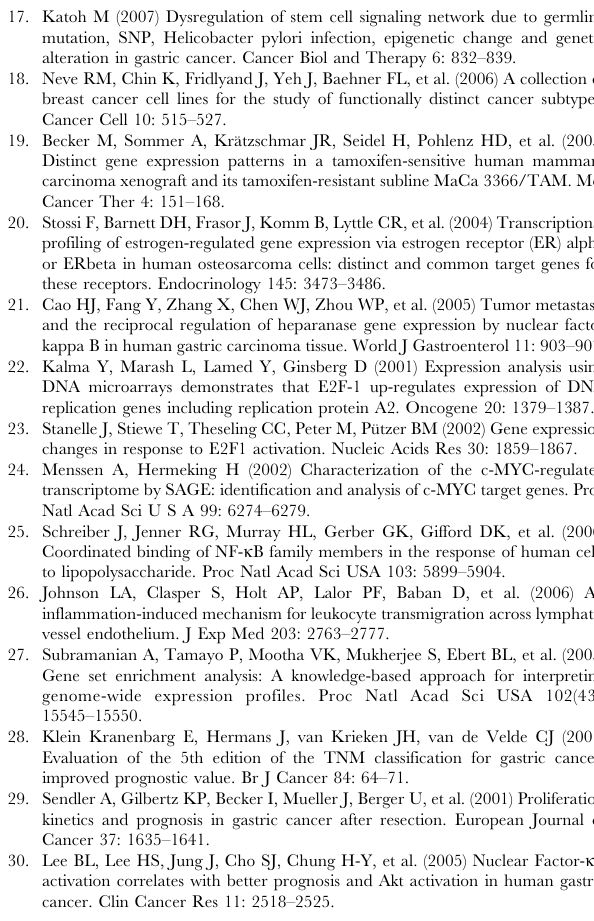
Table S8 Histopathological data for Cohort 1 of 70 tumors from Australia.